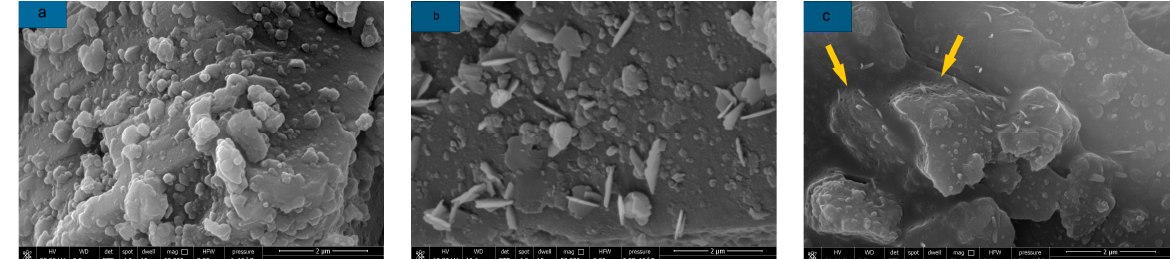
Figure 8. SEM images of samples with di ff erent borax dosages. ( a ) M0; ( b ) B2; ( c ) B6.